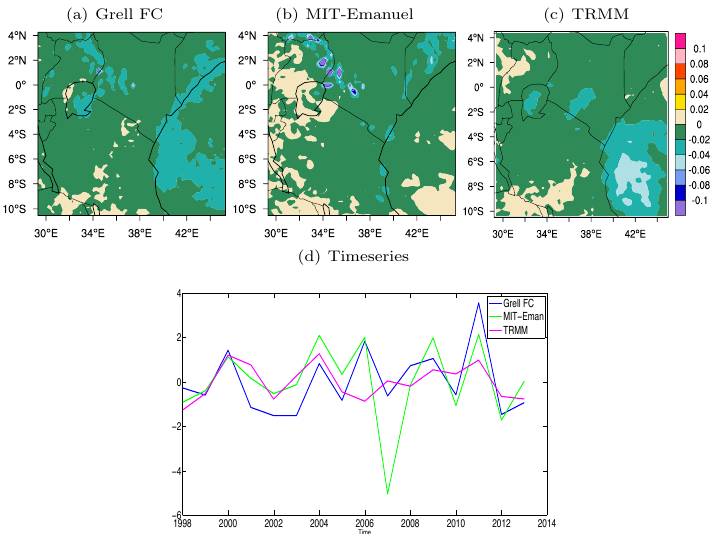
Figure 11. Spatial and temporal distribution for Long Rains EOF1 precipitation from models and observation ( a ) Grell FC, ( b ) MIT Emanuel, ( c ) TRMM, and ( d ) timeseries plot for EOF1 over East